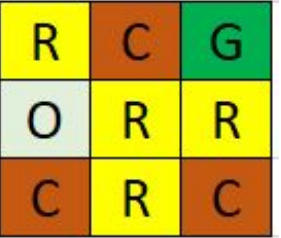
Figure 4. Land use distribution in a typical 3 × 3 cell zone.